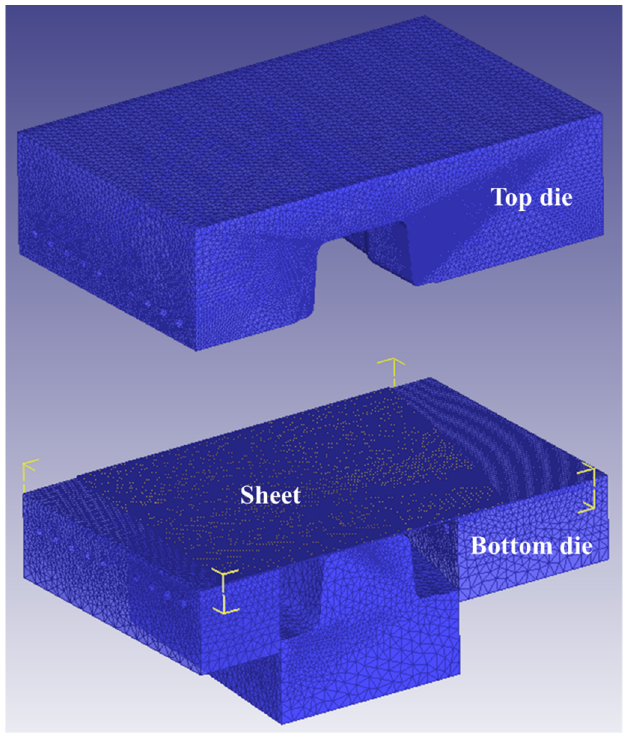
Figure 18. Finite-element model for gradient region of B-pillar.